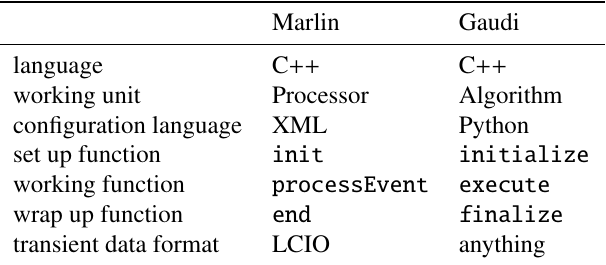
Table 1. Comparison between Marlin and